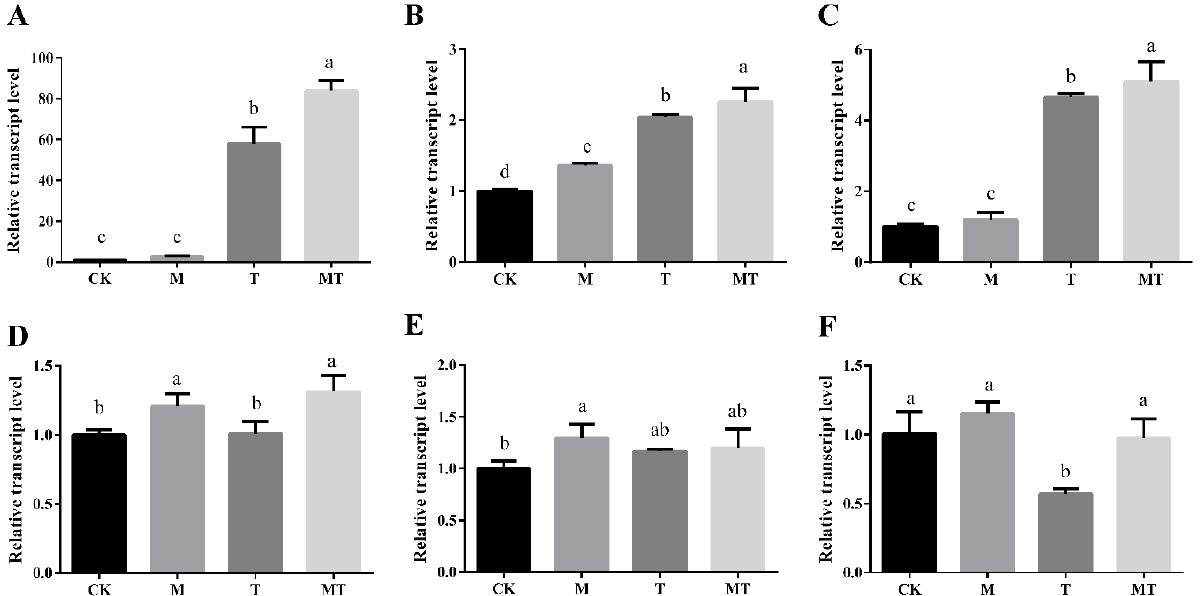
Figure 6. Expression patterns of cold-responsive genes in banana leaves from different groups. ( A – F ) MaChiI1 , MaCSDS1 , MaADA1 , MaHOS1 , MaWhy1 and MaKIN10 genes [13], respectively. Differ- ent letters above bars indicate a significant difference among samples determined using Duncan’s test at the p < 0.05 level. All the data are displayed as mean ± standard deviation for three replications. CK: control; M: melatonin treatment; T: low-temperature treatment; MT: combined melatonin and low-temperature treatment.